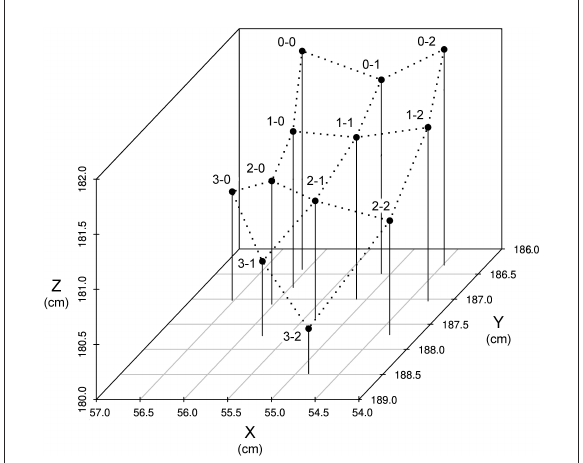
FIGURE1 3D coordinate (X, Y, and Z axes) by ball and strike count in the 4-seam pitch